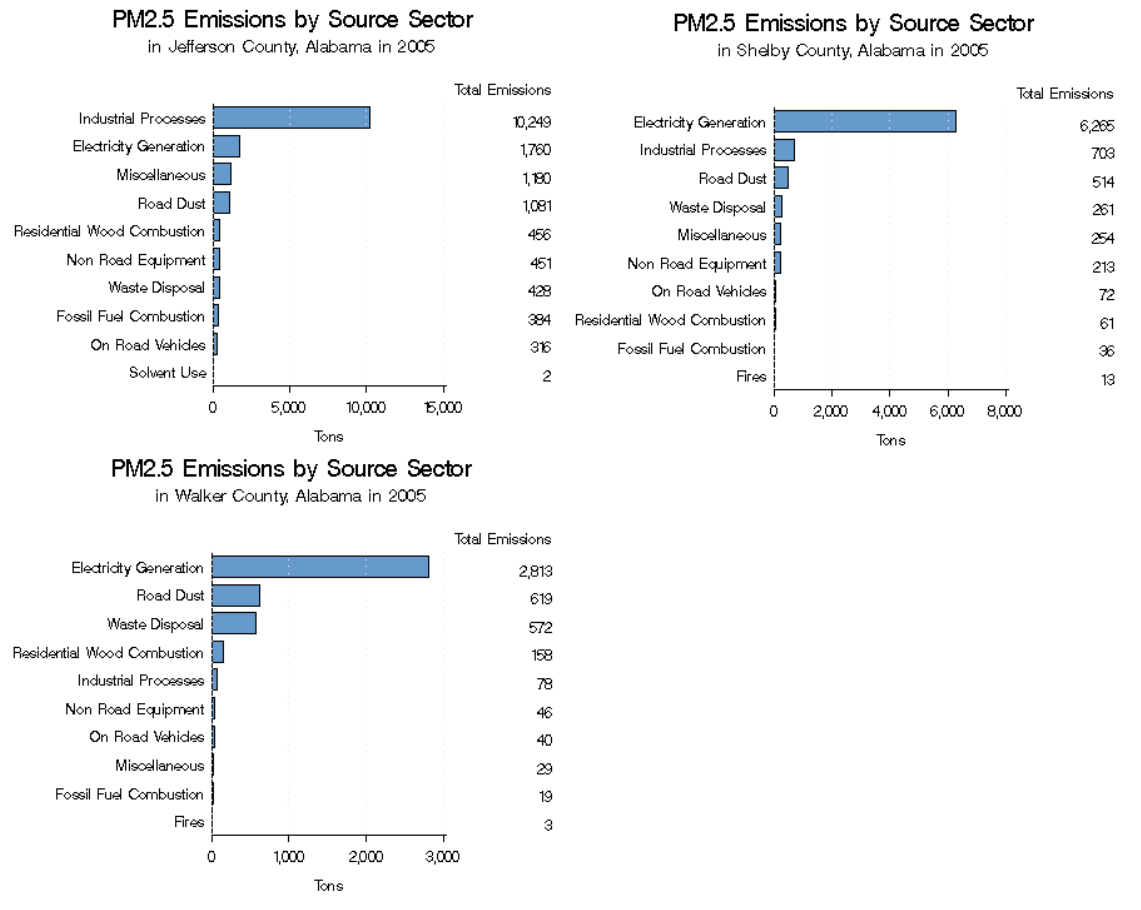
Figure 4. Breakdown of PM counties in